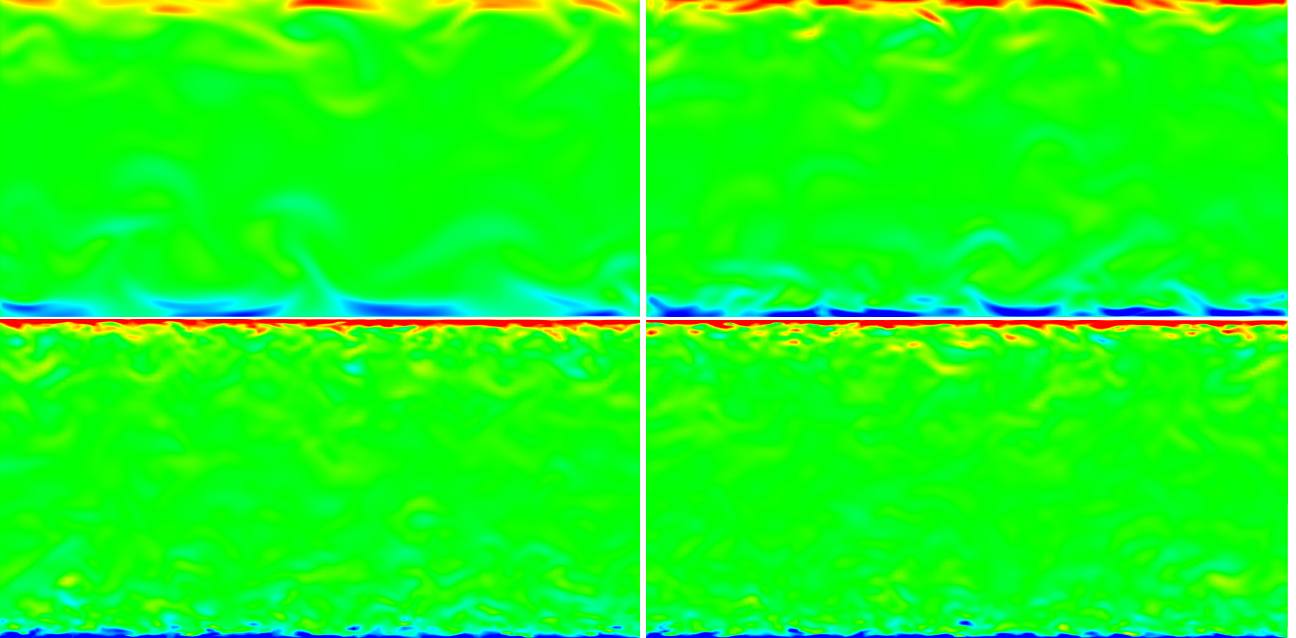
Figure 6. Fluid flow snapshots of streamwise micropolar velocity via 2D graphs in the Z − Y plane, from top to bottom: m = 0, Re = 3300; m = 0.9, Re = 3300; m = 0, Re = 13,800 and m = 0.9, Re = 13,800. Contour levels: −